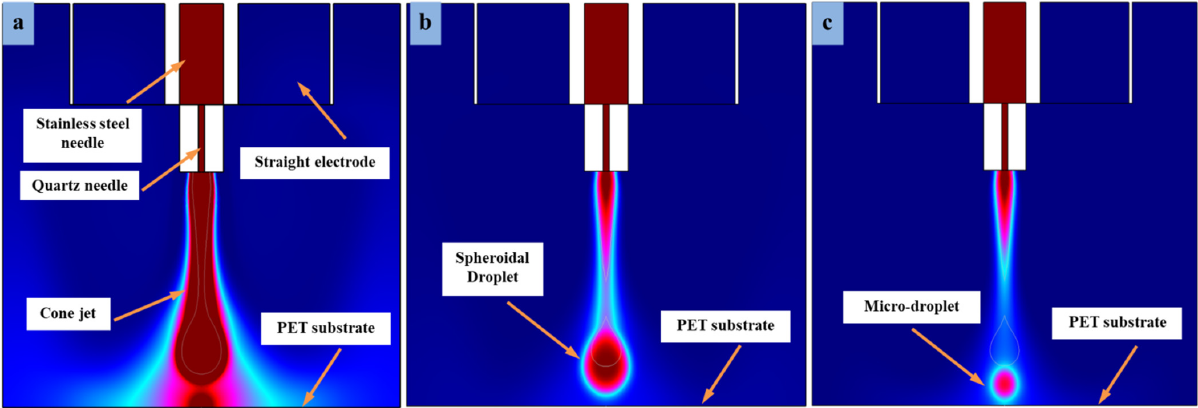
Figure 7. Different-sized microdroplets generated at different applied voltages regulated on com- bined needle and straight electrode, respectively: ( a ) 7.5 kV, 3.0 kV ( b ) 8.5 kV, 4.0 kV and ( c ) 9.0 kV, 4.5 kV.